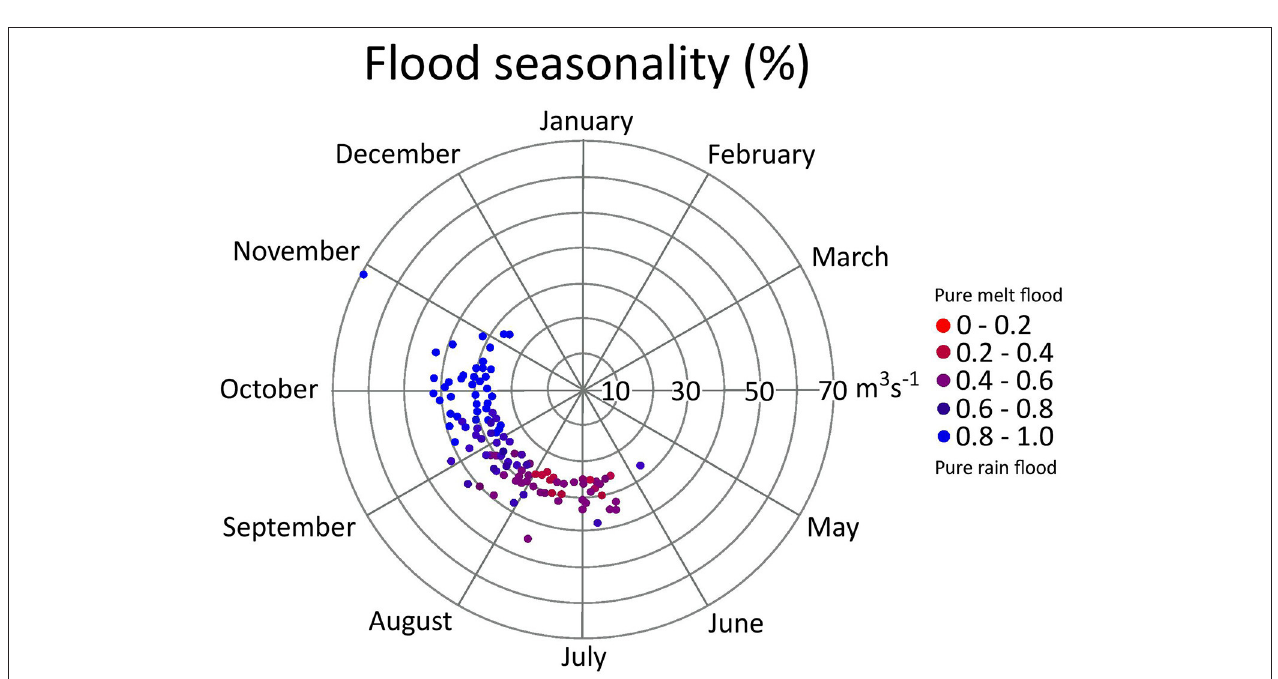
FIGURE 1 | Drainage catchment (black line) of the Buerdalen valley and the outlet glaciers at the head of the Jordalselvi stream [The Norwegian Water Resources Energy Directorate (NVE), 2020a]. The glacial outburst flood (GLOF) that occurred in 2002 went from a lake dammed at the outlet glacier Svartenutbreen to Lake Buervatnet (orange dashed line; Røthe et al., 2019). The inset shows southern Norway ( © EuroGeographics for the administrative boundaries) and the pink star marks Sandvinvatnet’s location. (B) Image of Lake Sandvinvatnet taken from the south direction (Photo: Jan Rabben). An image of Buerdalen valley can be seen in the Supplementary Material